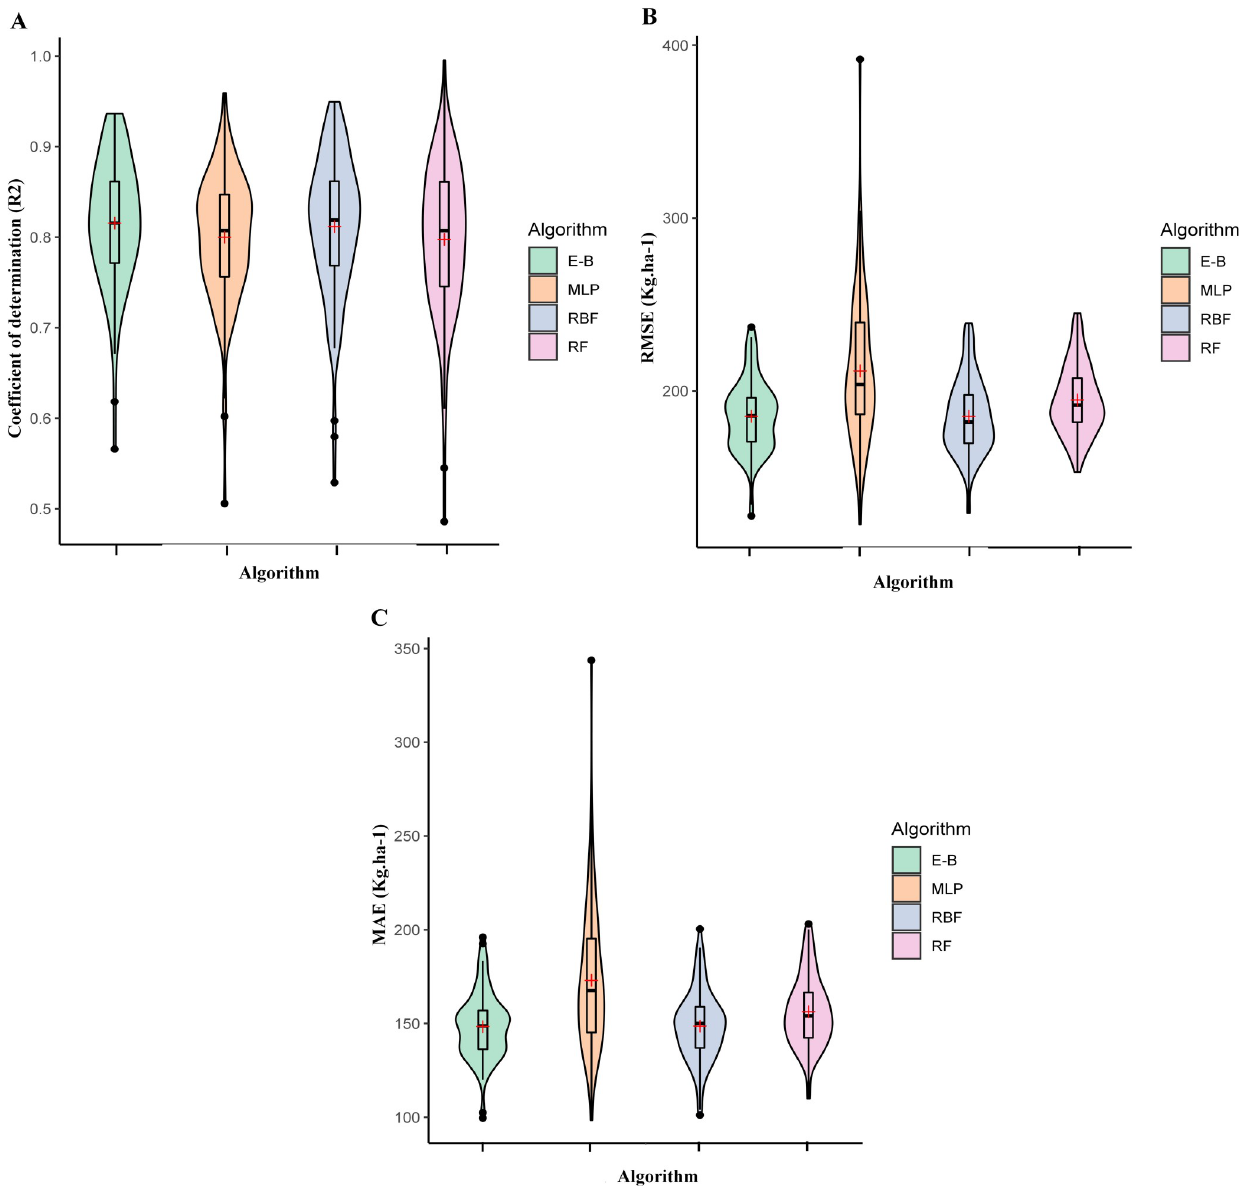
Fig 5. (A) coefficient of determination (R 2 ), (B) the Root Mean Square Error (RMSE) and (C) the Mean Absolute Errors (MAE) performance of Random Forest (RF), Multilayer Perceptron (MLP), and Radial Basis Function (RBF) algorithms, and the Ensemble-Bagging (E-B) strategy for soybean yield prediction using yield component traits. The mean performance is indicated with an + sign in each Figure.